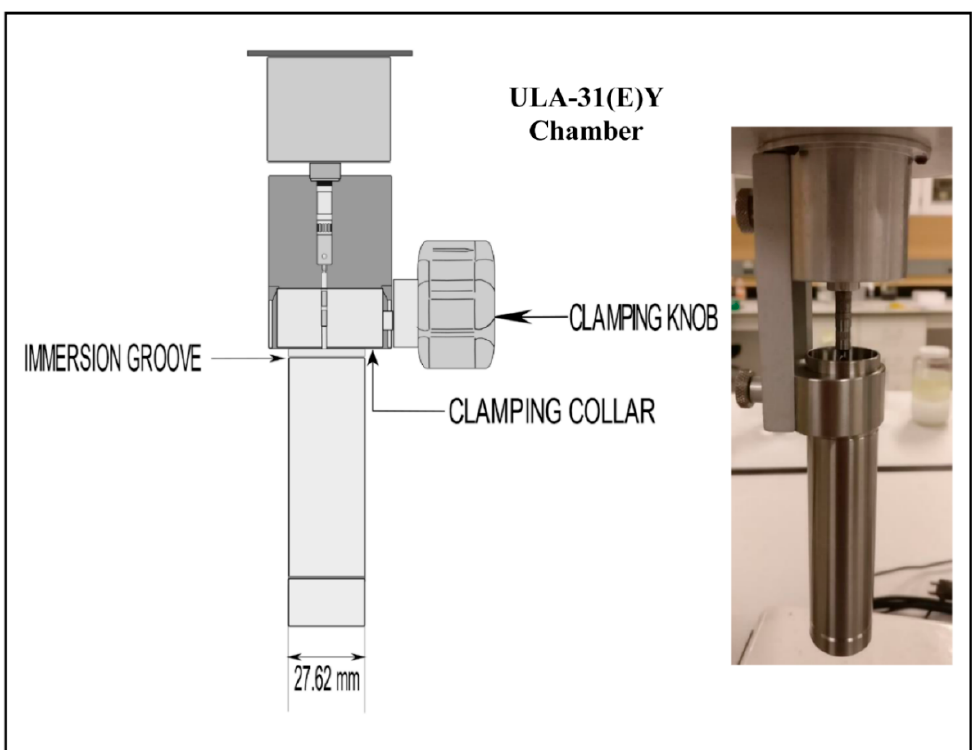
Figure 3. Enhanced UL adapter spindle assembly attached to the Brookfield LVT viscometer.